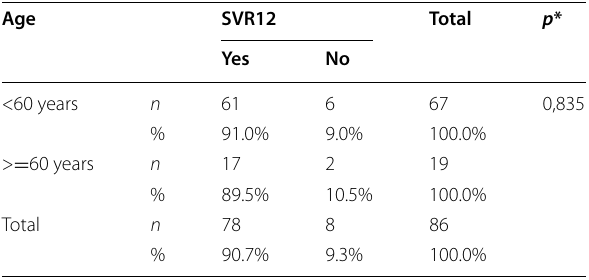
Table 3 Analysis of the correlation of age with